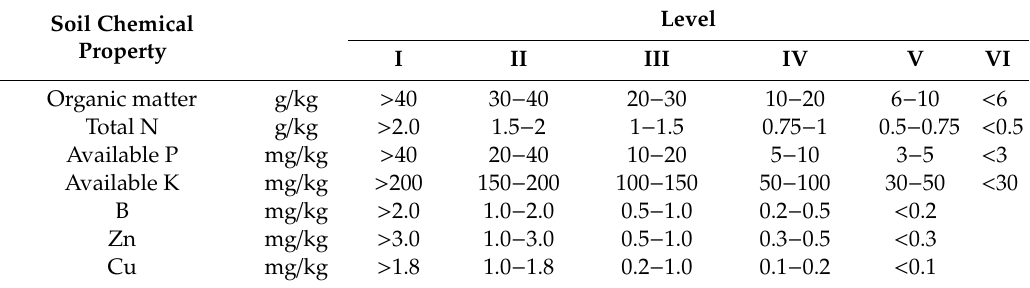
Table 7. Standard for nutrient classification of the second National Soil